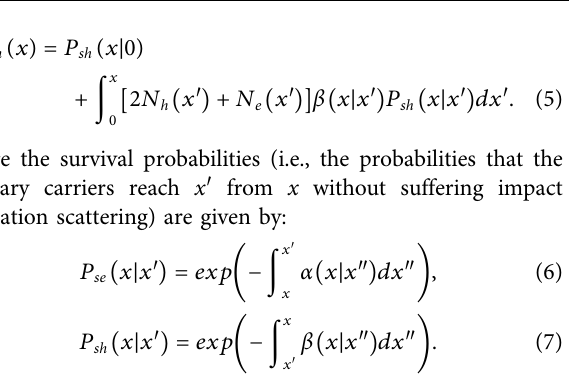
FIGURE 5 | Comparison between the local II model and the experiments in [23] for GaAs p-i-n diodes with different width of the intrinsic region. Plot (A) : gain vs. applied voltage. Plot (B) : excess noise factor vs. gain. II ionization rates are taken from [26].